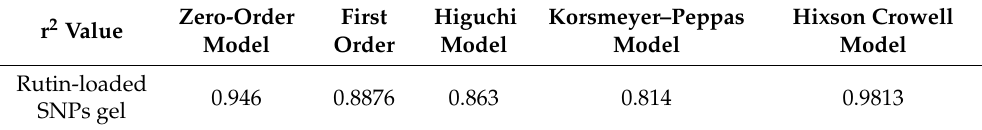
Figure 5. Comparative in vitro drug release study of rutin, rutin-loaded SNPs, and rutin-loaded SNPs gel for 600 min. Table 2. Release kinetics data of rutin-loaded SNPs.